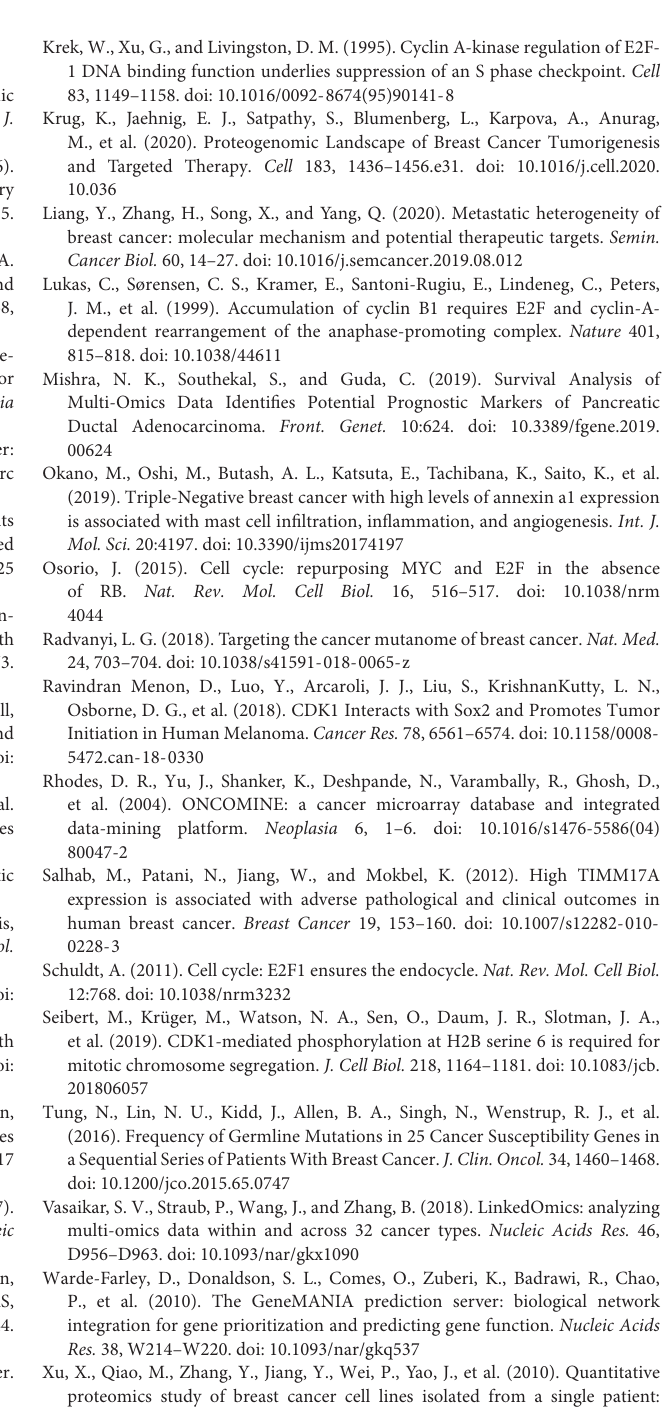
Supplementary Table 8 | The sequences of primers used for